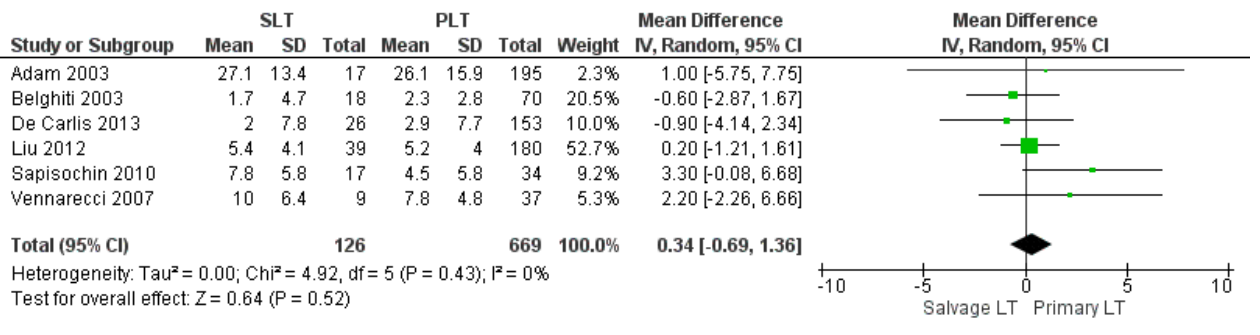
Figure 4. Intraoperative Red Blood Cell (RBC) transfusion.